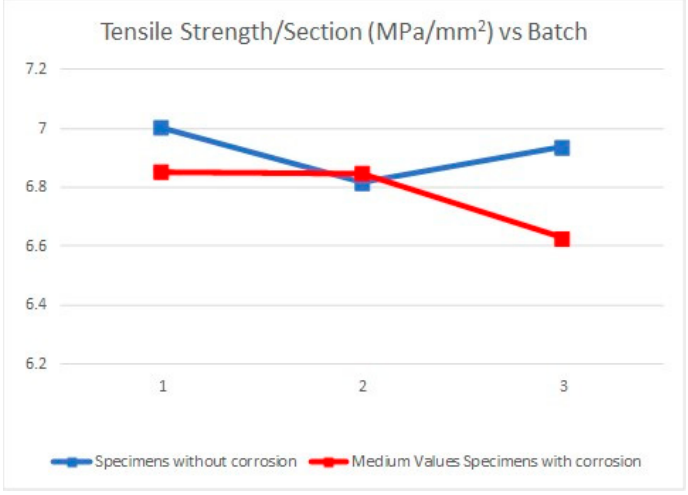
Figure 11. Tensile strength/Section vs. Batch. Table 10. Elongation/Section values per specimen and Medium values vs. Batch.